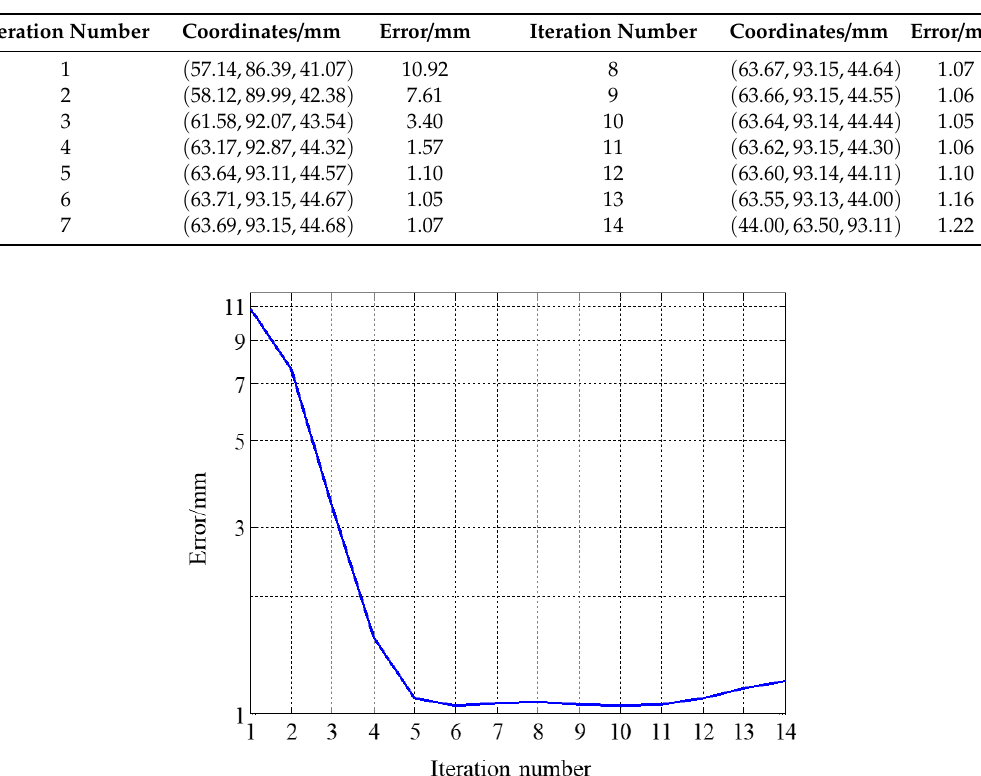
Table 2. The errors of localization results during each iteration.